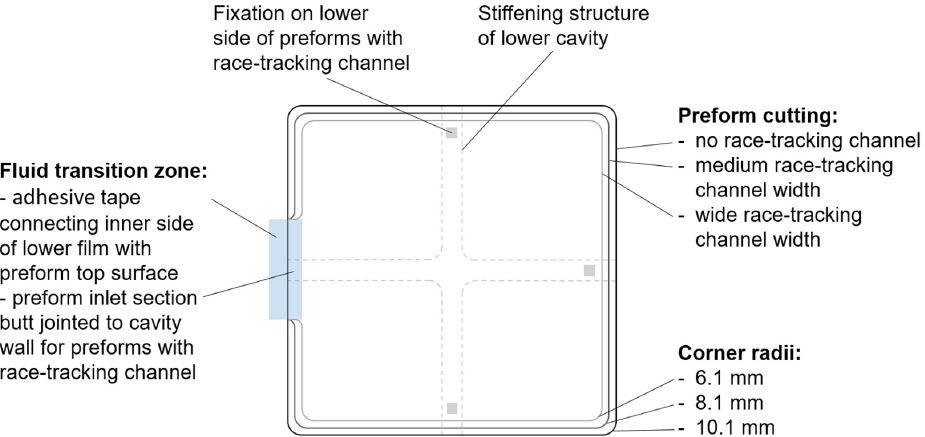
Figure 4. Schematic illustration of preform shapes including fluid transition zone and preform fixation on lower side of preforms with a race-tracking channel.